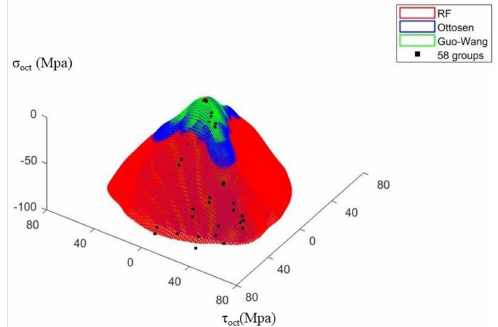
Figure 8. A 3D view of the failure surface.